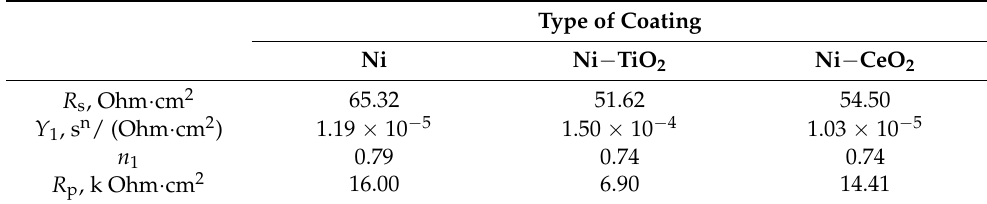
Table 7. Parameters obtained from the fitting of the impedance spectra after exposure to 0.5 M NaCl solution.